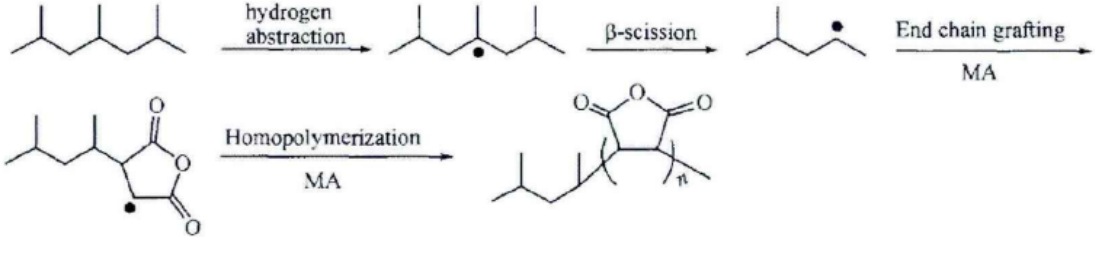
Figure 2. Polypropylene grafting mechanism